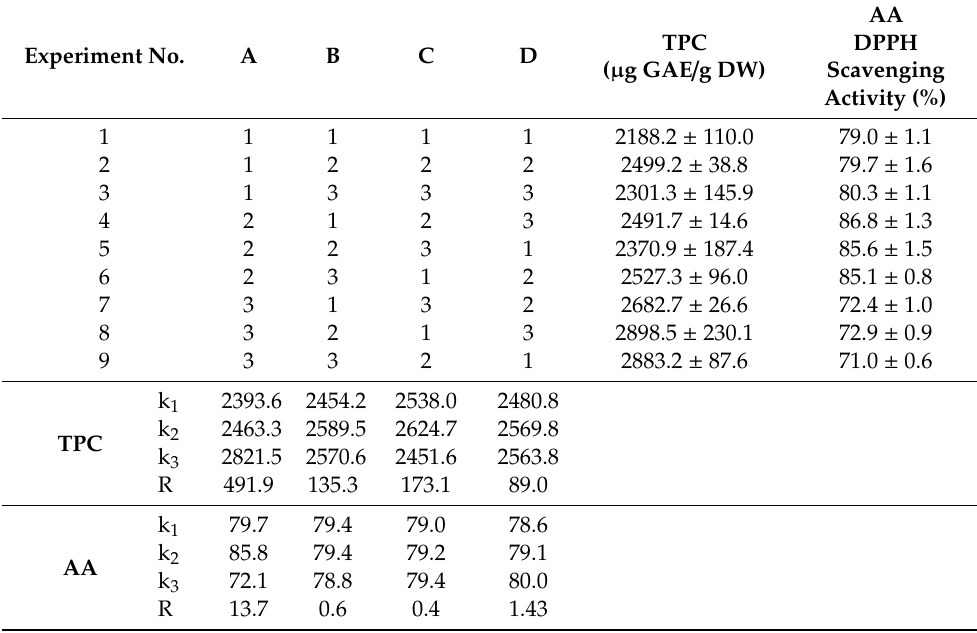
Table 5. L 9 (3 4 ) Orthogonal experiment for extraction of BWB.